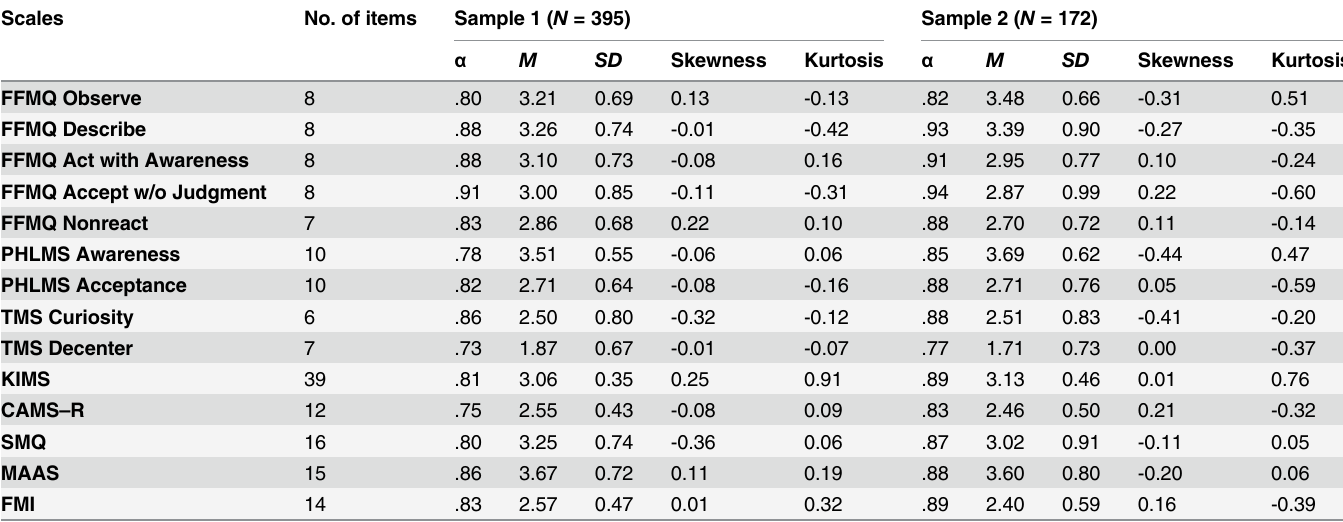
Table 2. Descriptive Statistics and Properties of Mindfulness